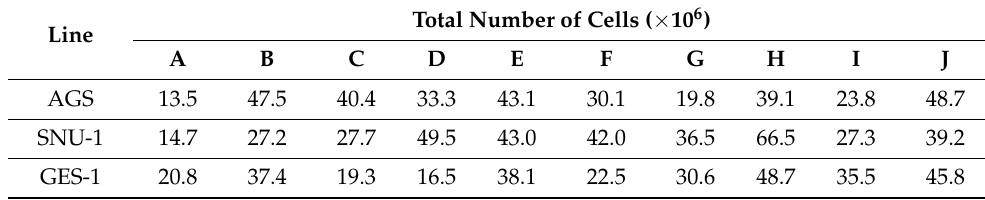
Table 2. Total number of cells ( × 10 6 ) in the cultivation flasks at the time of the measurement.